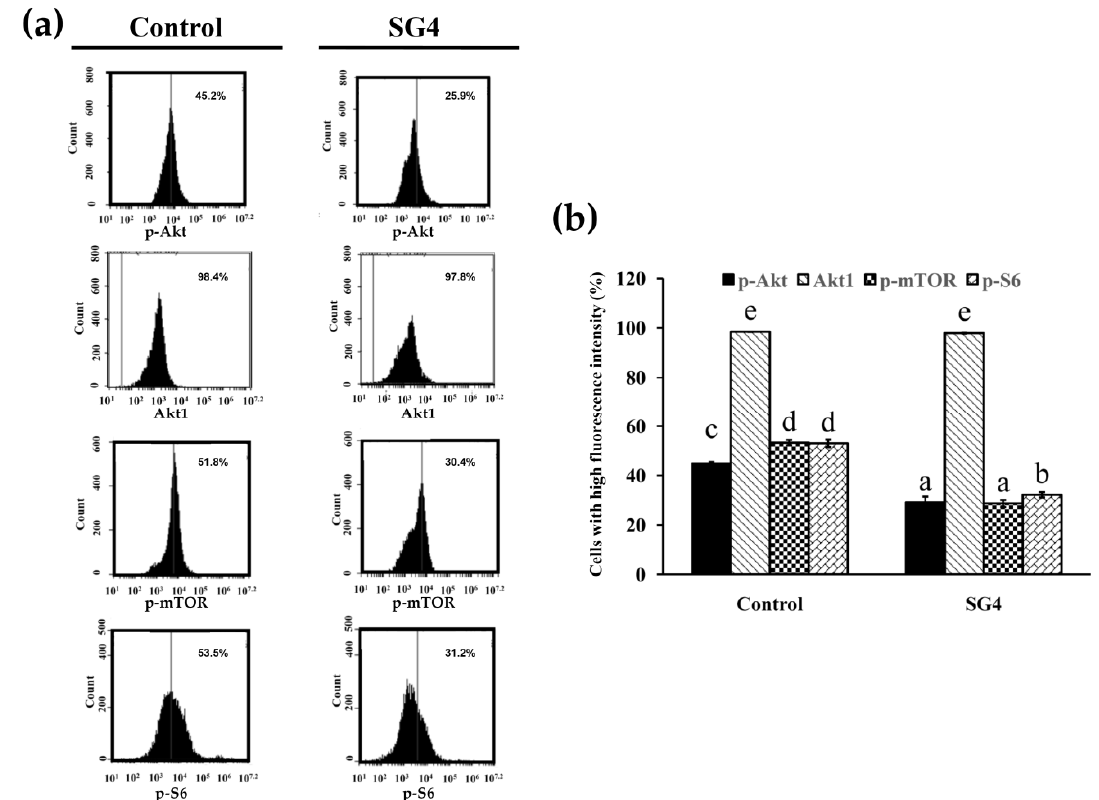
Figure 7. The expression of p-Akt, Akt1, p-mTOR, and p-S6 in HT-29 cells treated with 200 µ g / mL SG4 for 48 h: ( a ) In the histograms, x axis and y axis denote p-Akt, Akt1, p-mTOR, or p-S6 content and cell counts, respectively. The percentage of cells with mean channel fluorescence values above the marker border is indicated in each histogram; ( b ) the percentage of cells with high fluorescence of p-Akt, Akt1, p-mTOR, and p-S6 is presented as determined for ( a ). The experiments were performed in triplicate. Di ff erences existing between columns are labeled with di ff erent letters, p < 0.05.